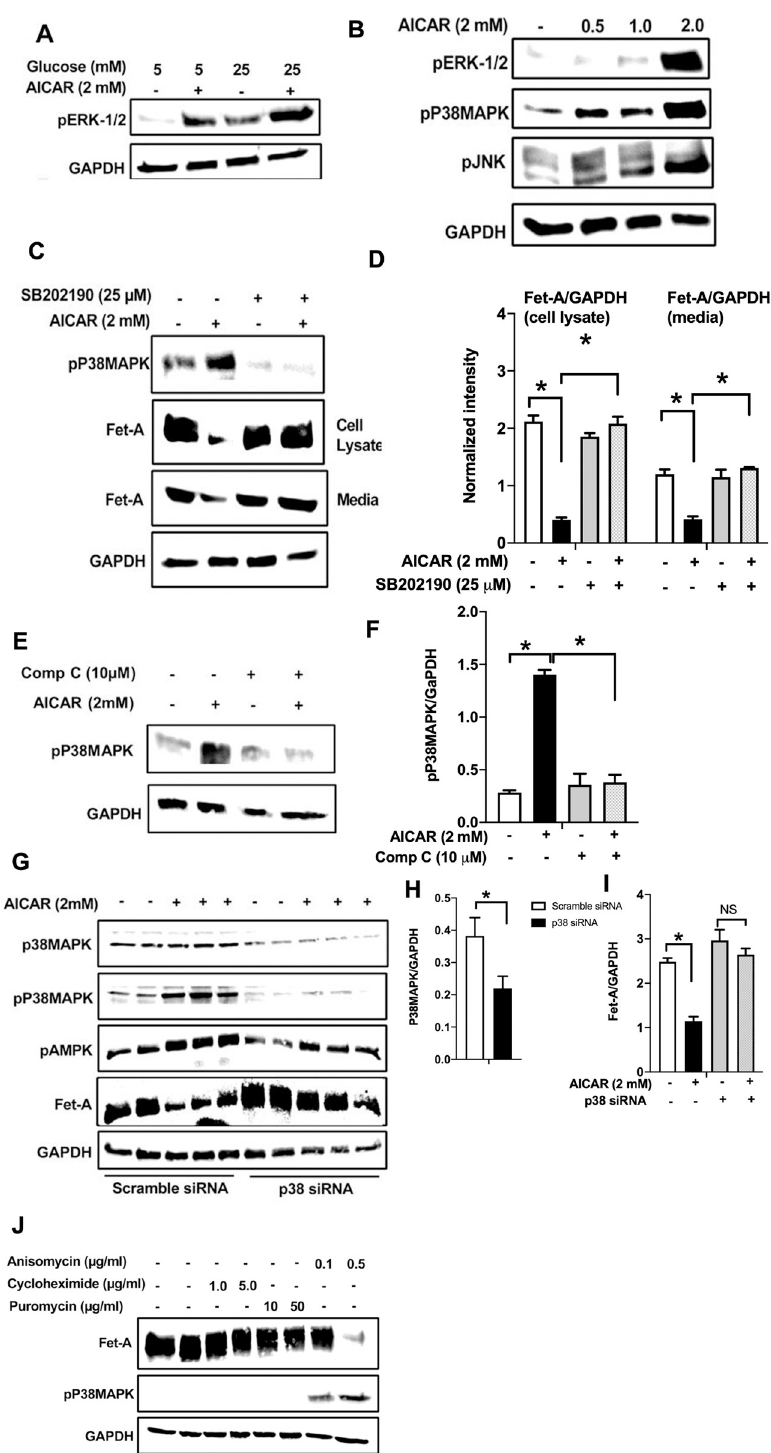
Fig 3. AMPK activation downregulates Fet-A expression through p38 MAPK. [A] HepG2 cells were incubated with either low- or high-glucose in the absence or presence of AICAR for 12hr and used for Western blot analysis for ERK1/ 2 phosphorylation expression (n = 3). [B] HepG2 cells were incubated with different concentration of AICAR for 12 h and cell lysates were analyzed by Western blotting for ERK1/2, p38MAPK and JNK phosphorylation (n = 3). [C] Cells were treated with p38 MAPK inhibitor [SB202190, n = 4] before treatment of AICAR for 12 hr. Cell lysate or media